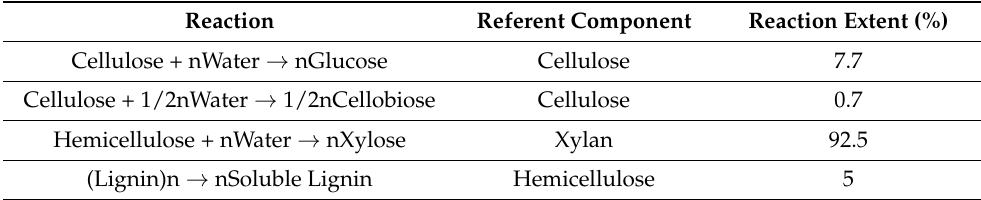
Table 1. Pretreatment reactions with reaction